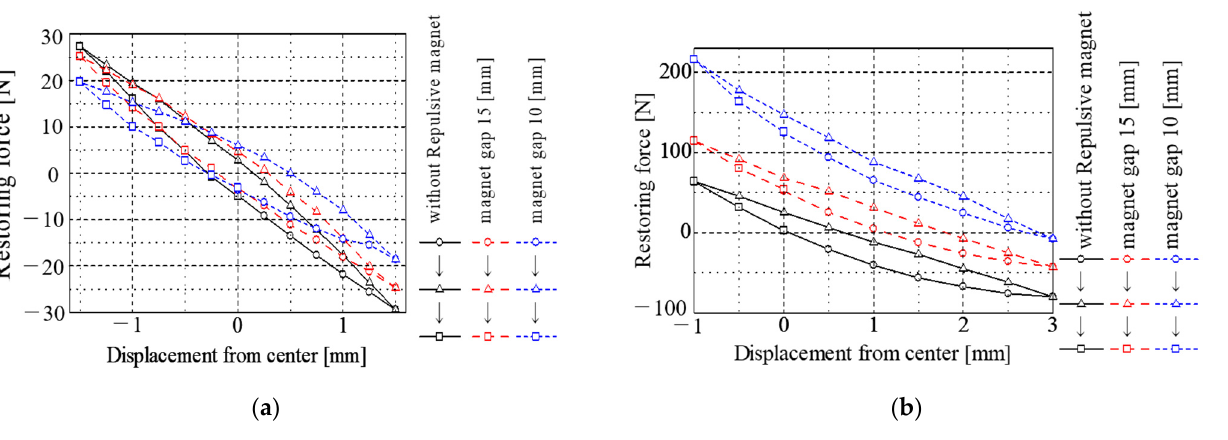
Figure 9. Measurement results of restoring force in each direction: ( a ) Radial measurement results, ( b ) Axial results.